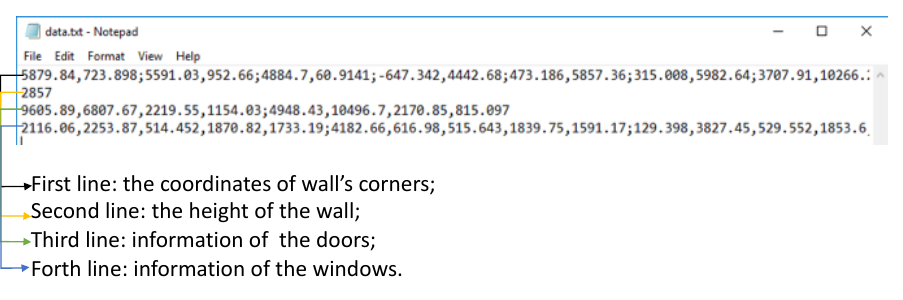
Figure 13. The example of the output geometry information of elements.